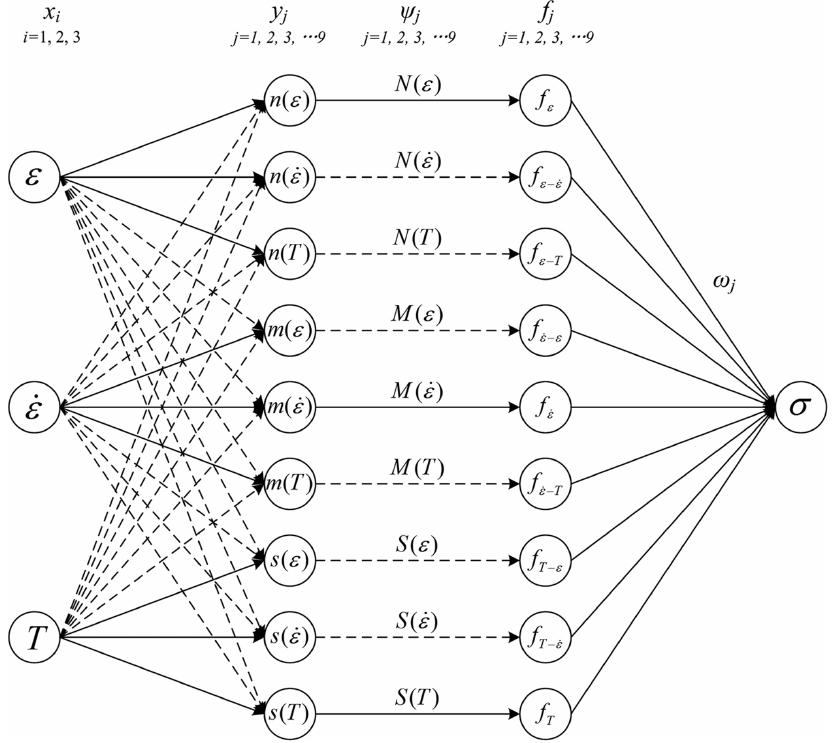
Figure 4: Relationship between flow stress and test factors as well as analysis